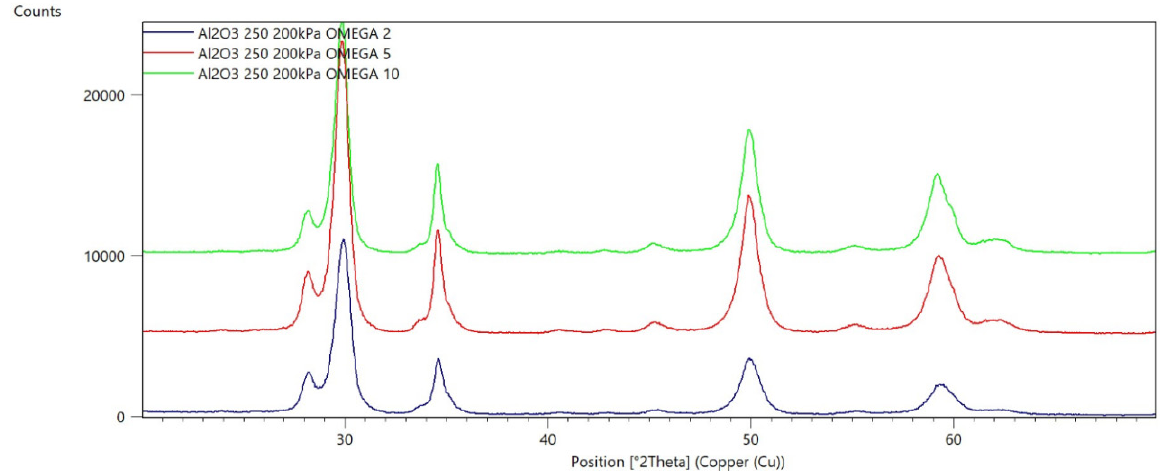
Figure 6. Diffraction patterns of sample E (abrasive—Al 2 O 3 250 μ m, pressure 200 kPa).